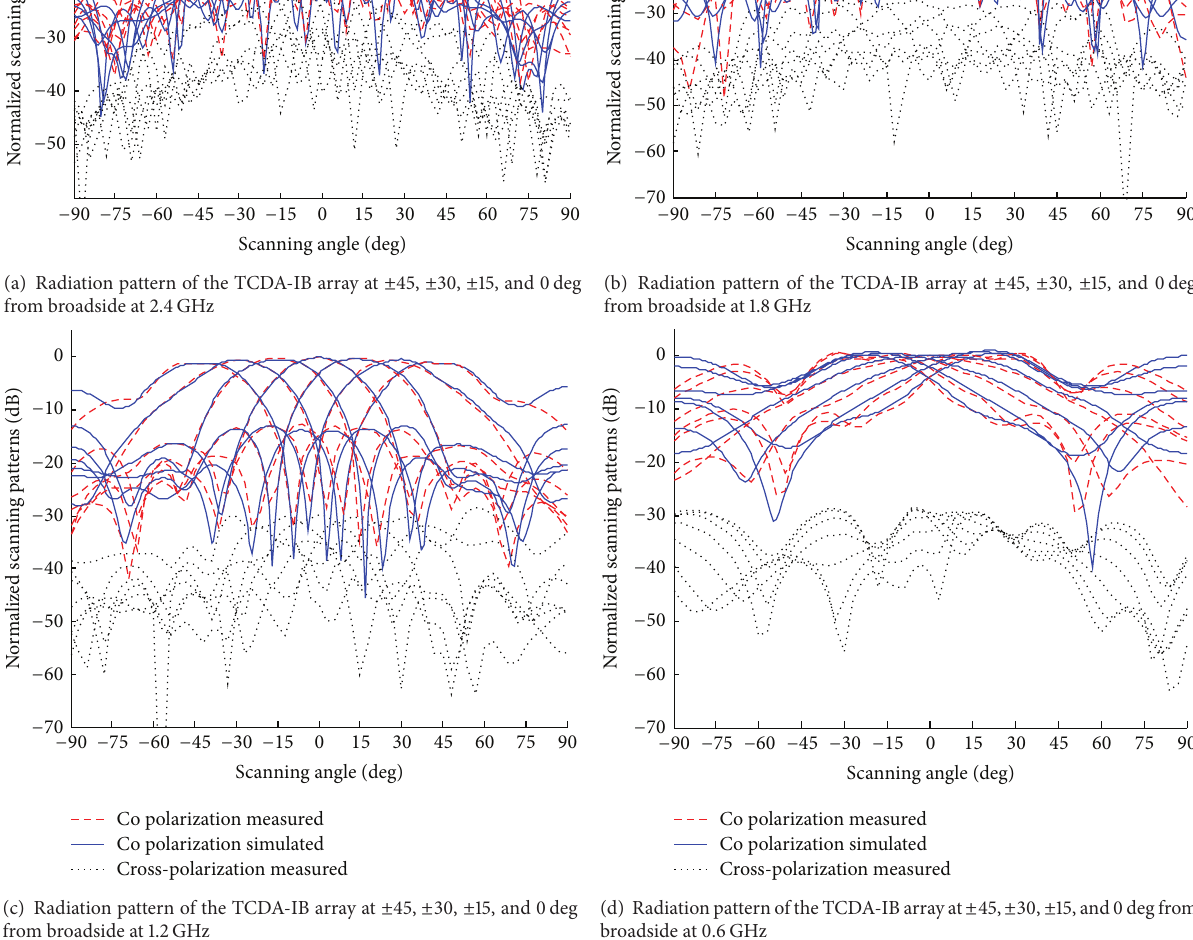
Figure 13: E-plane scanning for the TCDA-IB array defined in Figures 5–9. Comparison of measured versus simulated patterns at various scan angles. The measured cross-polarization levels are also